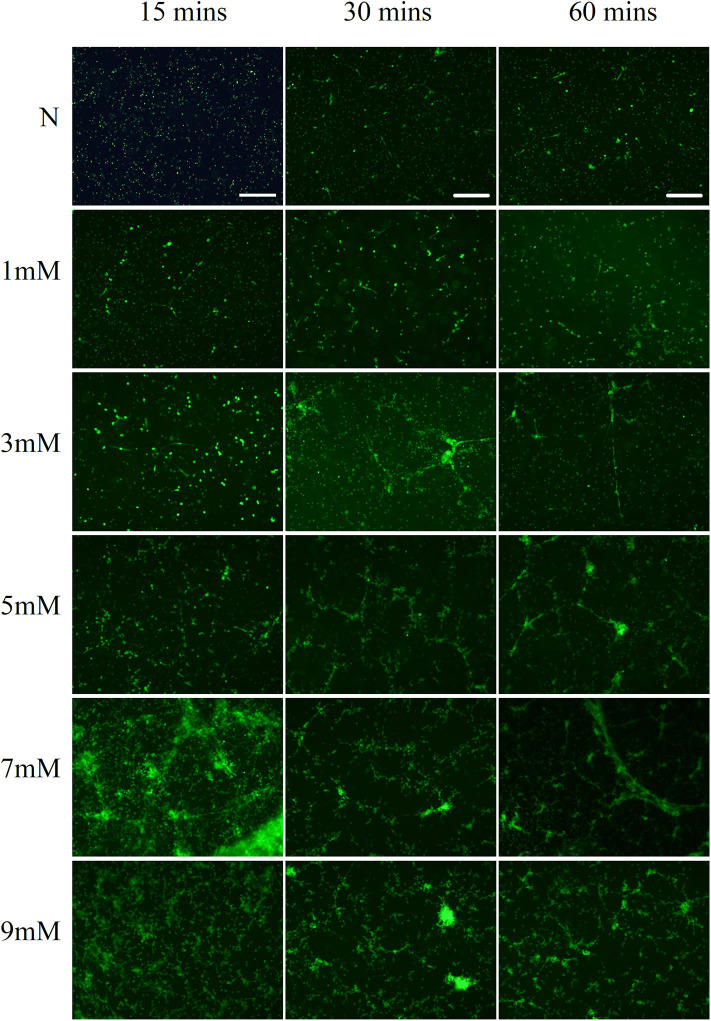
Alkali induces dose- and time-dependent NETs formation. Alkali triggered dose- and time-dependent NETs formation as demonstrated by SYTOX green staining. While only a few NETs structures were observed 60 min after 1 mM NaOH and 3 mM NaOH treatment, 5 mM NaOH stimulation for 30 min induced significant NETs generation. Moreover, many neutrophils died and detached as early as 15 min after both 7 mM NaOH and 9 mM NaOH treatment. Bar: 250 μm.